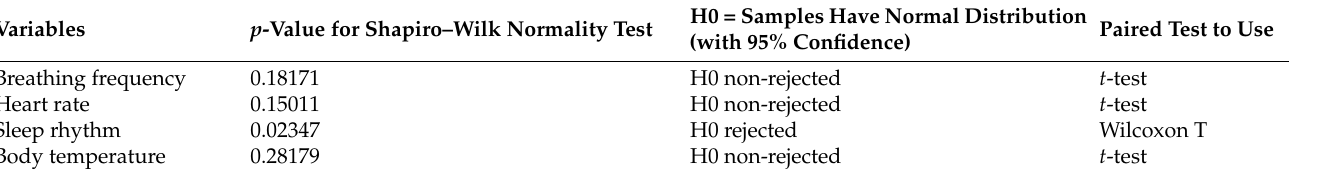
Table 11. Normality test for male subjects and corresponding paired test to use.